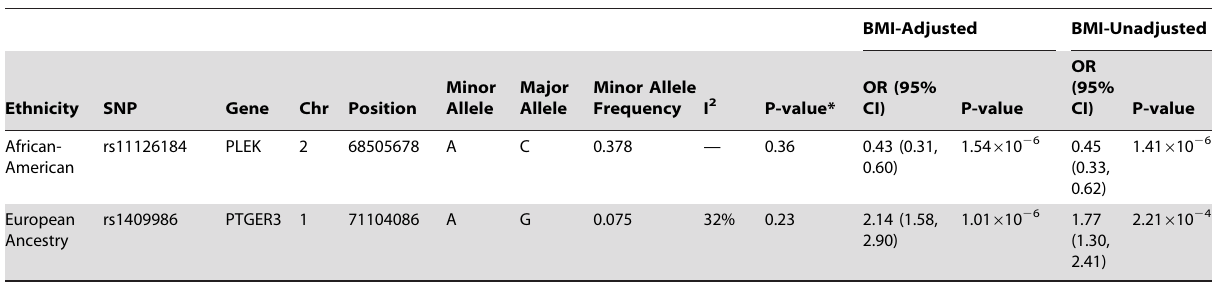
Table 3. SNPs associated with OSA.